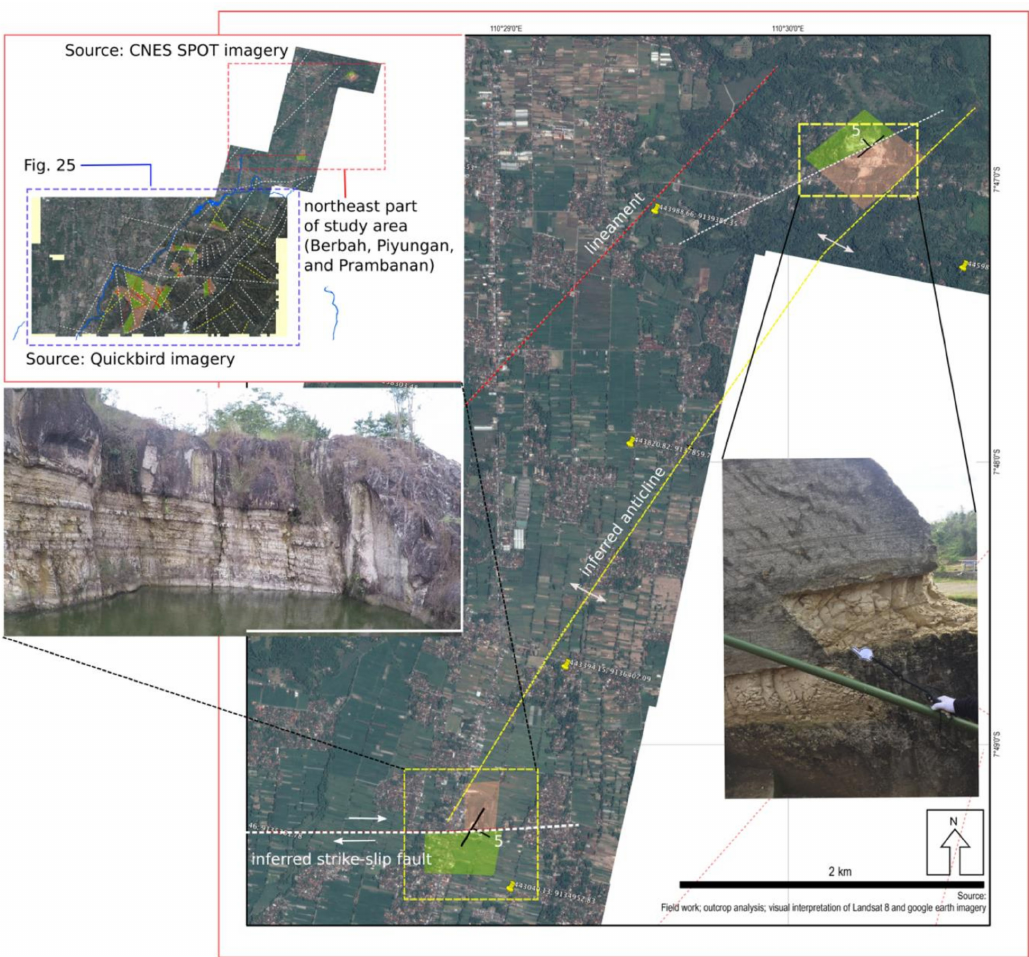
Figure 21. The outcrop reconstruction in the northeast part of the study